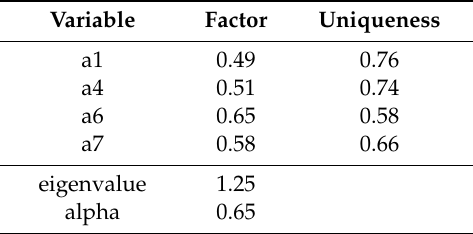
Table A3. Factor loadings using Factor with highest alpha.